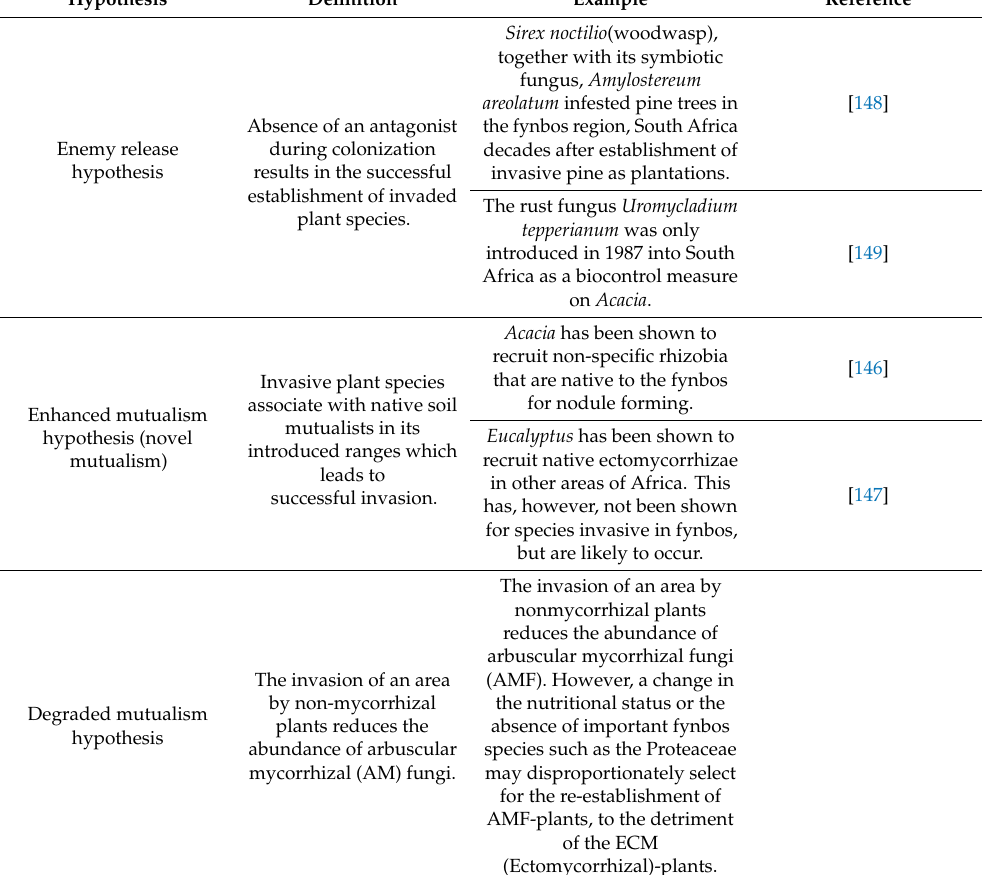
Table 1. Di ff erent hypotheses that relate to the contribution of invasion success of non-native plants, by microbial interactions with examples from the fynbos biome (Adapted from